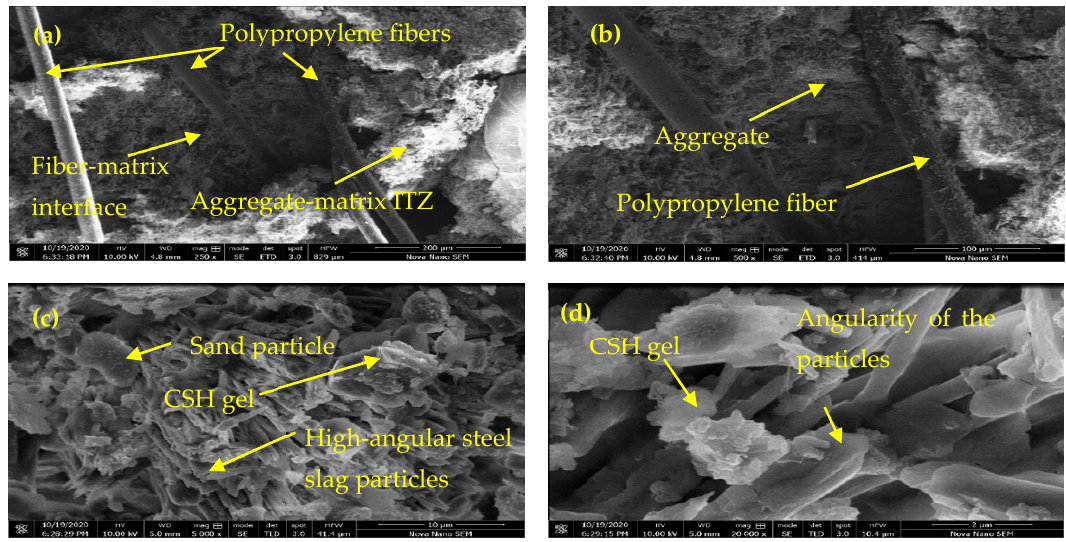
Figure 14. Microstructure analysis of fiber-reinforced slag concrete ( a ) bridging action of PP fibers. ( b ) enlarged view of PP fibers. ( c ) effective coating of cement particles around fine aggregates. ( d ) high-angular steel slag.